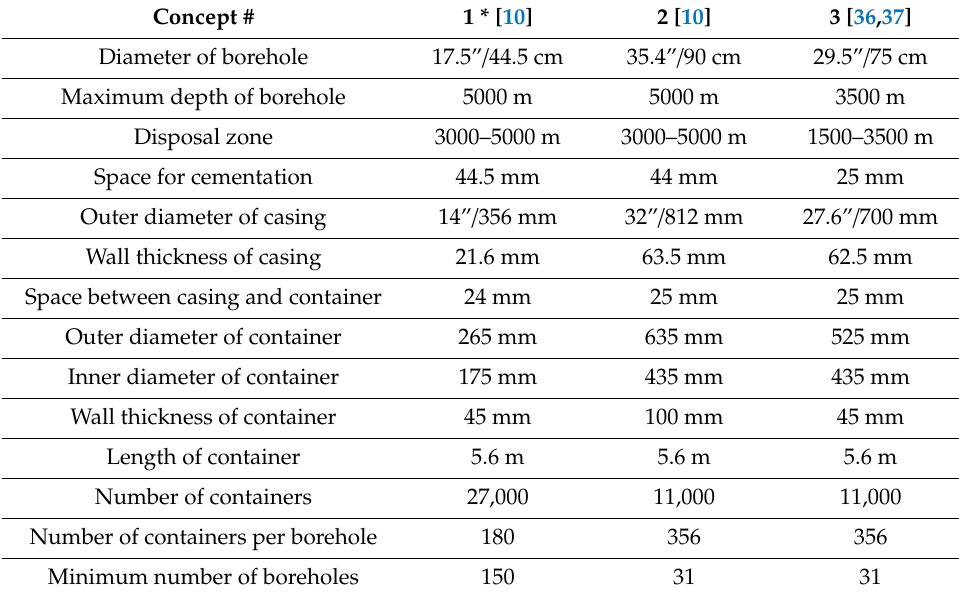
Table 4. Technical data for di ff erent concepts in Germany